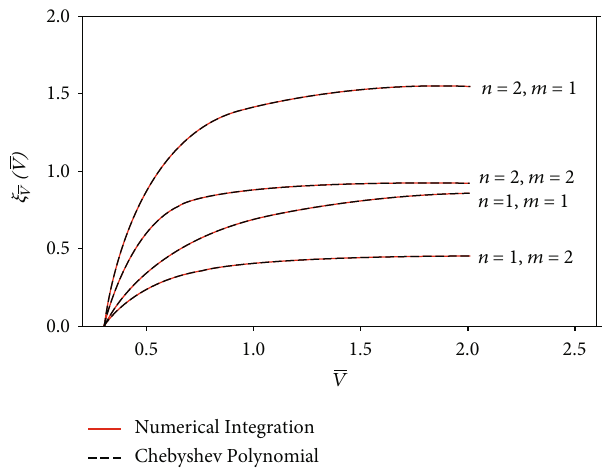
(cid:2) ð V Þ with various n and m V